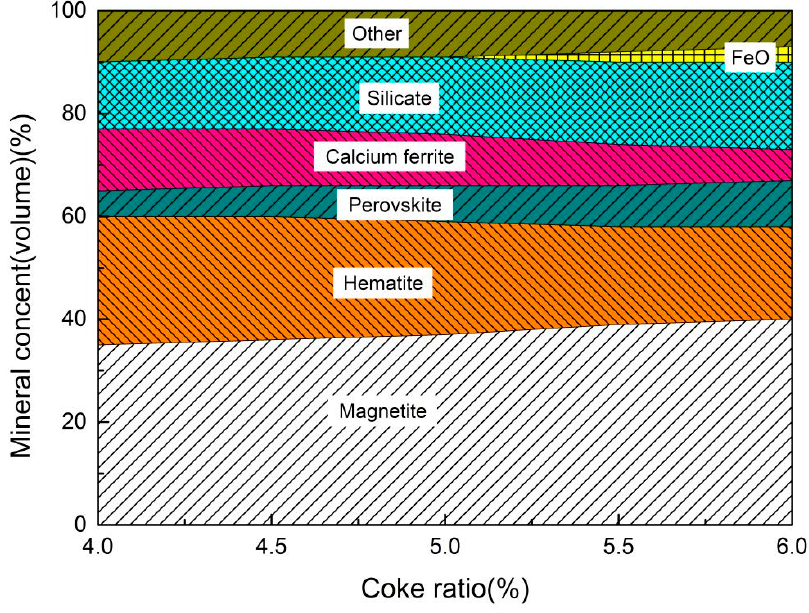
Figure 8. Effect of the coke ratio on the HCVTS mineral content.